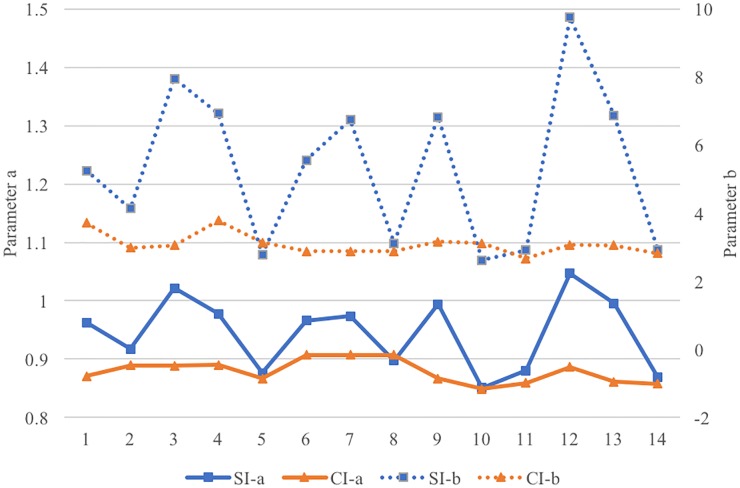
The values of parameter a and b in SI and CI. (The values of parameter a is shown in the left column of y-axis and the value of parameter b is shown in the right column.)